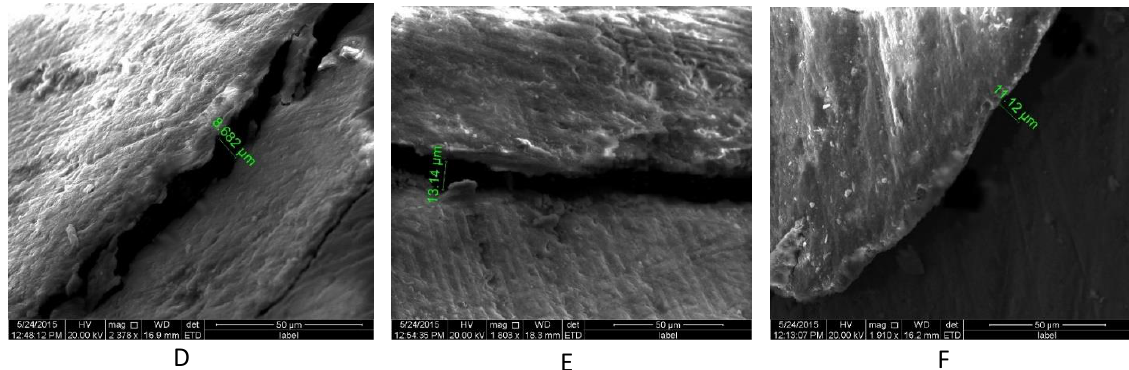
Figure 4: (A) Represent gaps of group A1 (B) Represent gaps of group A2 (C) Represent gaps of group A3 (D) Represent gaps of group B1 (E) Represent gaps of group B2 (F) Represent gaps of group B3 Table 1: Composition of the two universal adhesives bonding used Materials Composition Single Universal Adhesive